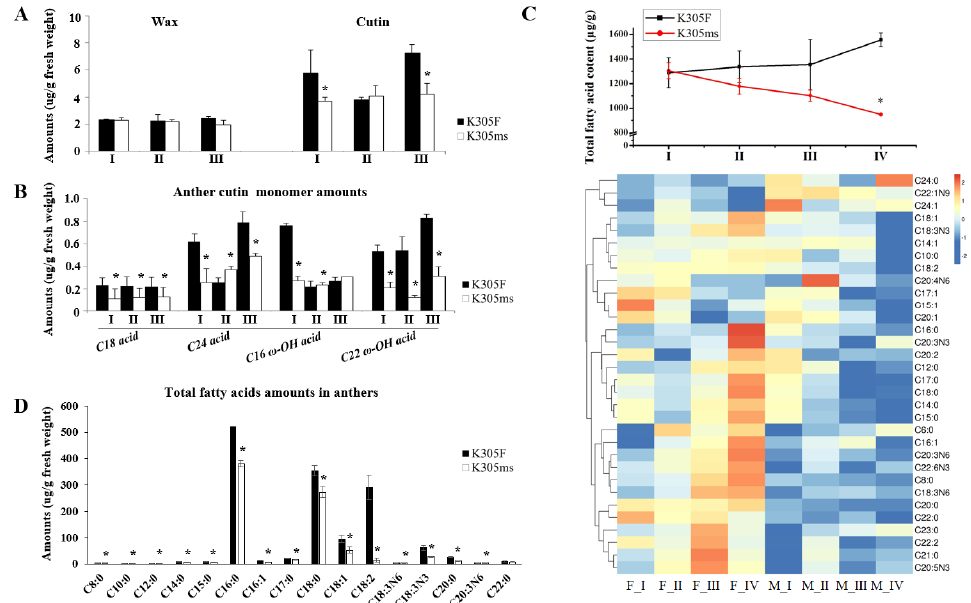
Figure 5. Aliphatic alteration of ms305 anther. ( A ) Cutin and wax amounts of ms305 (K305ms) and fertile sibling (K305F) in pollen mother cell (I), dyads (II), and tetrad stages (III), respectively. ( B ) The major differential cutin monomers between ms305 and fertile sibling anther. ( C ) Total fatty acids of ms305 and fertile sibling anthers in different development stages. ( D ) Alteration of ms305 fatty acids amounts in microspore stage. I, pollen mother cell; (II), dyads; (III), tetrad; (IV) microspore. Error bars indicate SD ( n = 5); * p < 0.05.